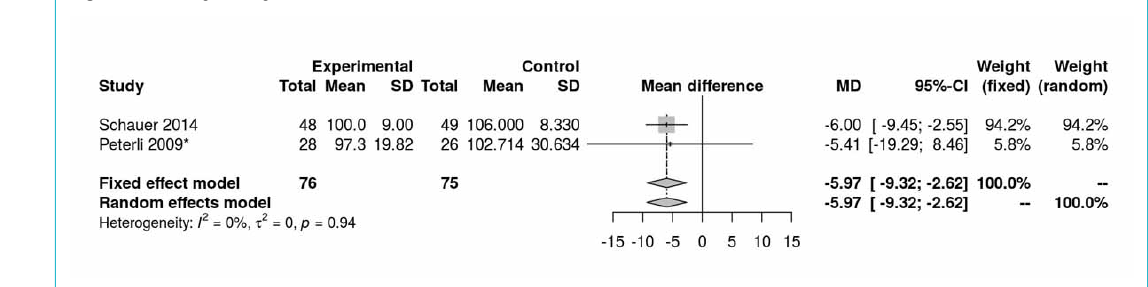
Figure 2e: Fasting blood glucose at 36